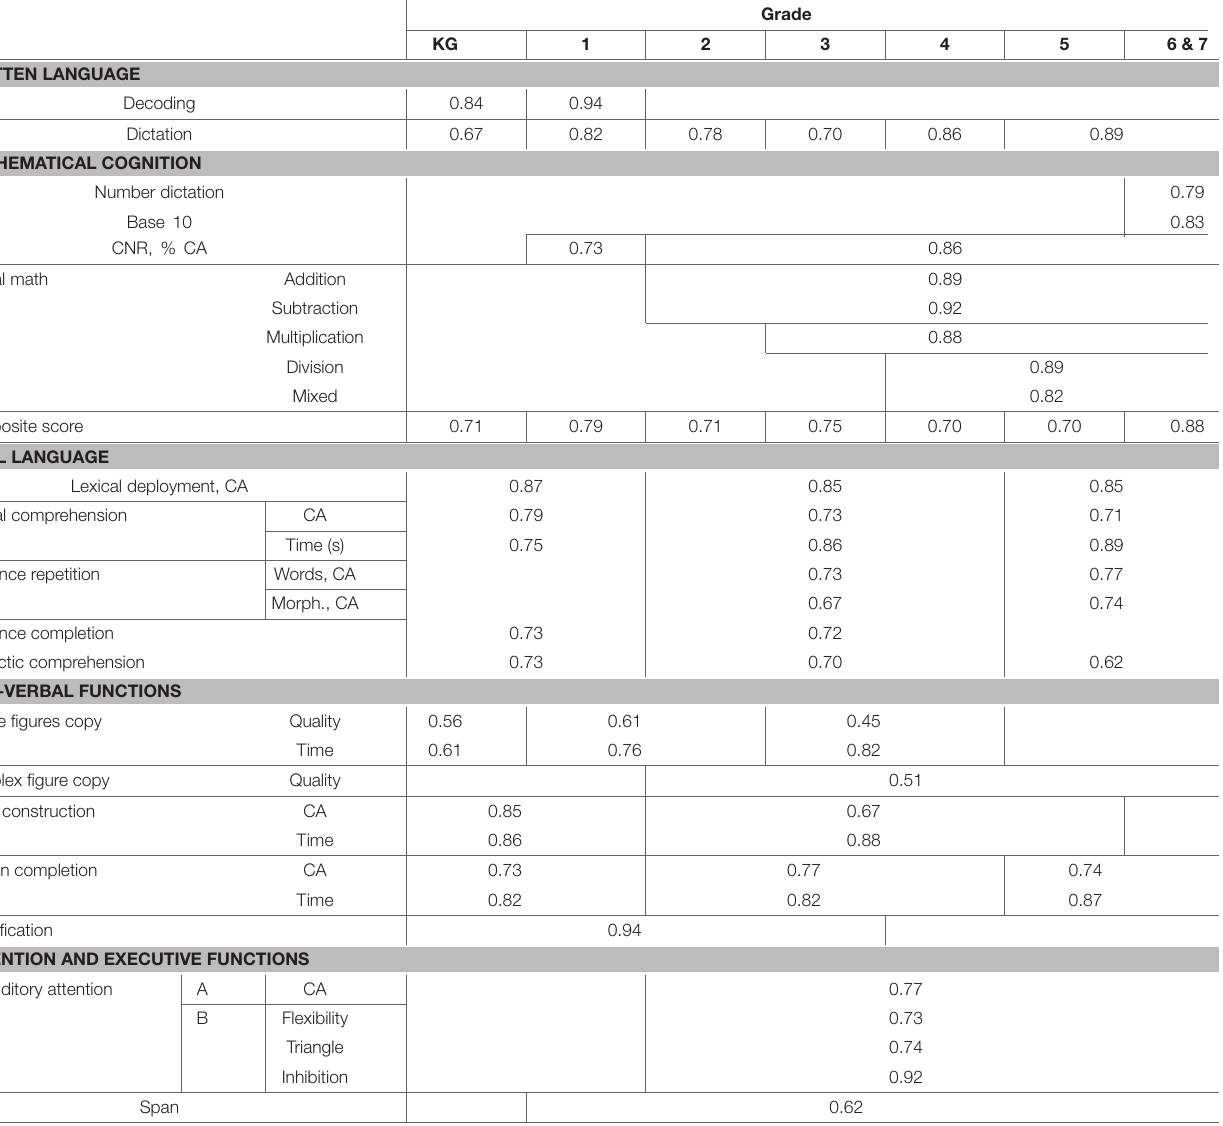
TABLE 5 | Internal consistency of BMT- i test scores.